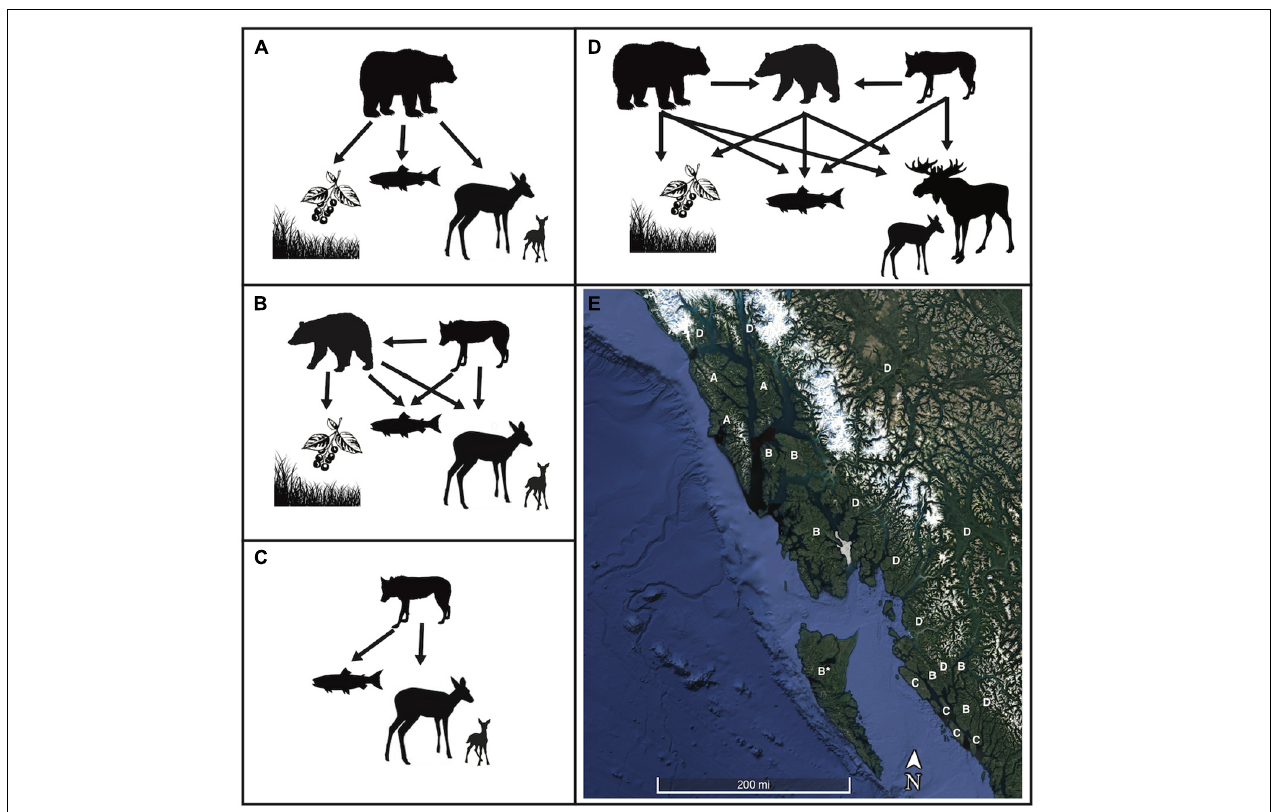
FIGURE 3 | Food web motifs in salmon-bearing ecosystems including bears that primarily eat salmon and berries but seasonally prey on ungulate calves, and wolves that prey on ungulates and seasonally consume salmon and marine resources. These food web motifs vary across the archipelagic landscape in Southeast Alaska and British Columbia. (A) The brown bear–deer system is uncommon, but is characteristic of Admiralty, Baranof, and Chichagof islands. (B) The black bear – wolf – deer system characterizes most of the inner islands of this archipelagic landscape, while (C) wolf – ungulate systems occur on the outer islands of British Columbia. (D) Large mammal food webs on the mainland are more diverse, containing brown bears, black bears, wolves and typically moose in the north transitioning into deer to the south. (E) The spatial distribution of these large mammal food webs in Southeast Alaska and British Columbia. The remote island of Haida Gwaii is labeled “B*” because it is a unique black bear system without wolves and with deer being an introduced